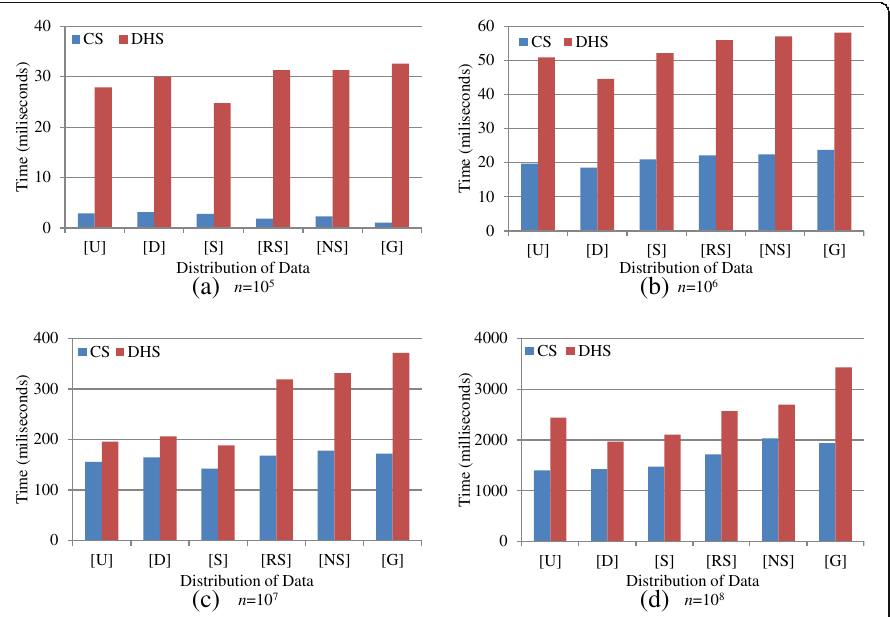
Fig. 4 Running time for the CS and DHS algorithms in case of O ( m ) = O ( n ). a n = 10 5 . b n = 10 6 . c n = 10 7 . d n = 10 8